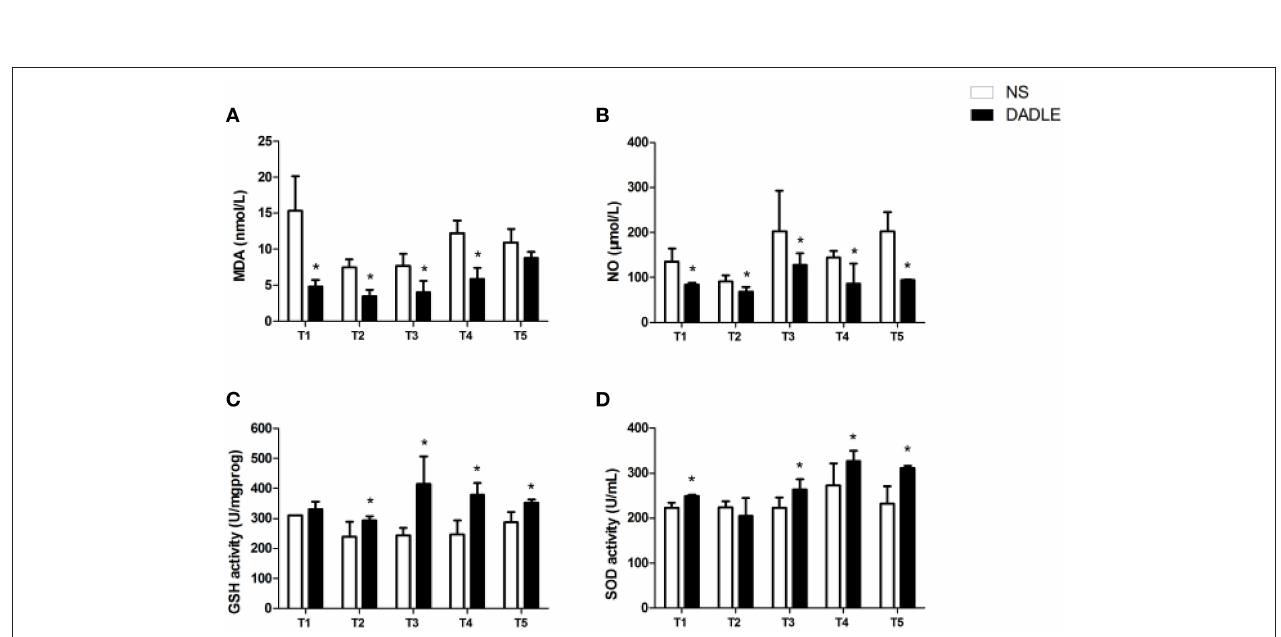
FIGURE 2 | DADLE-induced decrease in MDA and NO levels and increase in GSH-Px and SOD levels in spinal cord I/R injury. (A) The effects of DADLE on MDA activity. (B) The effects of DADLE on NO activity. (C) The effects of DADLE on GSH-Px activity. (D) The effects of DADLE on SOD activity. T1 = the onset of reperfusion; T2 = 1h after reperfusion; T3 = 6h after reperfusion; T4 = 24h after reperfusion; T5 = 48h after reperfusion. Differences in means in NS and DADLE groups at each time point were analyzed using two-way ANOVAs followed by the Bonferroni post hoc test. Bars represent mean ± SD ( n = 8). * P < 0.05 vs. the NS